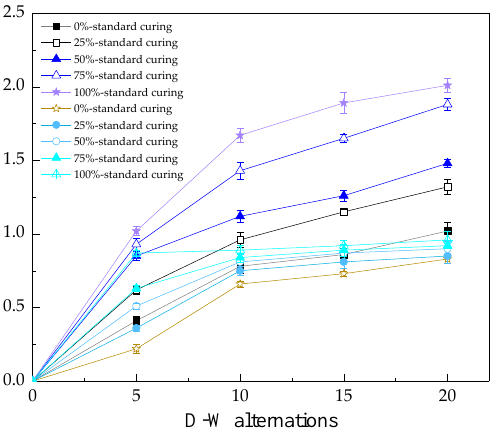
Figure 3. △ m/m of the reinforced alkali-activated mineral admixtures during D – W alternations. The mass loss rate of the reinforcement is exhibited in Figure 4. It can be observed that the mass loss rate of reinforcement increases with the increasing NaCl D – W alterna- tions and the addition of BFS, due to the increased corrosion degree by D – W alternations and the corrosion resistance by BFS. Meanwhile, CO 2 curing demonstrates a positive effect on the corrosion resistance of the reinforcement [41,42]. The result of the reinforcement’s mass loss rate is consistent with the mass loss rate of the reinforced alkali-activated mineral admixtures.